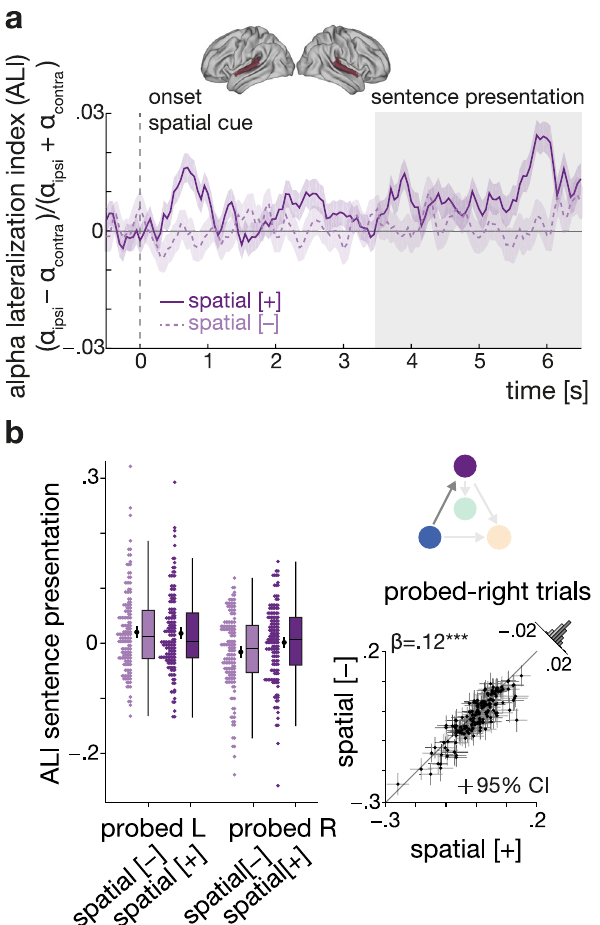
Fig. 3 Informative spatial cue elicits increased alpha-power lateralization before and during speech presentation. a Grand-average ( N = 155 participants) whole-trial attentional modulation of 8 – 12Hz auditory alpha power. Purple traces show the grand-average alpha lateralization index (ALI) for the informative (solid dark purple line) and uninformative spatial cue (dashed light purple line), each collapsed across semantic cue levels. Error bands indicate ±1 SEM. Positive values indicate relatively higher alpha power in the hemisphere ipsilateral to the attended/probed sentence compared to the contralateral hemisphere. The shaded grey area shows the time window of sentence presentation. Brain models show the auditory region of interest (red). b ALI during sentence presentation (3.5 – 6.5s) shown separately per spatial-cue condition and probed ear (left plot) for N = 155 participants. Coloured dots show trial-averaged individual results, black dots and error bars indicate the grand-average and bootstrapped 95% con fi dence intervals. Box plots show median centre line, 25th to 75th percentile hinges; whiskers show minimum and maximum within 1.5×interquartile range. For probed-right trials, there was a signi fi cant difference in ALI between selective- and divided- attention trials (right plot). Black dots represent individual mean ALI values with bootstrapped 95% CI error bars. Histogram shows the distribution of differences in ALI for informative vs. uninformative spatial-cue levels. β : slope parameter estimate from the corresponding general linear mixed-effects model; two-sided Wald test (FDR-corrected, *** P = 2.65×10 − 17 ). Source data are provided as a Source Data fi